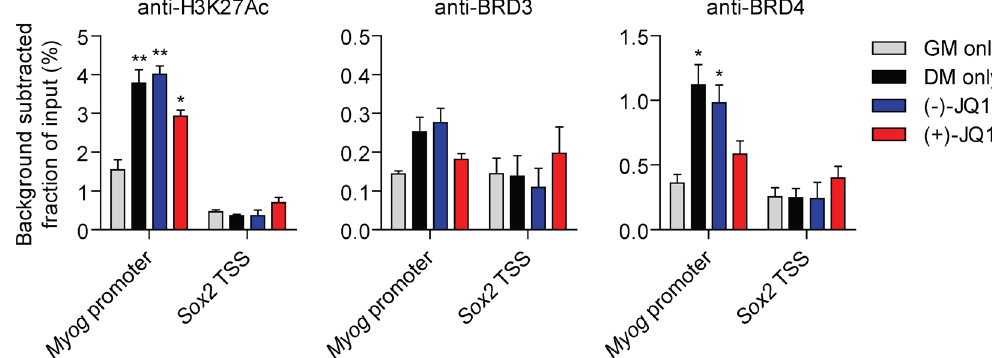
Figure 8. BRD4 is enriched at the Myog promoter during myogenic differentiation. Chromatin was harvested from undifferentiated C2C12 cells (two days in GM), differentiated cells (2 days in GM, followed by 3 days in DM), and differentiated cells treated with either ( − )-JQ1 or ( + )-JQ1 (1 μ M). Sonicated chromatin was precipitated with anti-H3K27Ac, anti-BRD3, anti-BRD4 or IgG (negative background control) antibodies. Genomic DNA was amplified by qPCR using primers for the Myog promoter or the Sox2 TSS (a putative negative control locus). Enrichment is expressed as the fraction of non-precipitated input samples after subtraction of the background IgG signal. For BRD3, one way ANOVA analysis was significant ( P = 0.0399), but no pairwise Bonferroni post test reached significance at the P < 0.05 level. All values are mean + SEM, n = 3 independent experiments, statistical comparisons are to the GM only group, * P < 0.05, ** P < 0.01, *** P < 0.001 (one-way ANOVA, Bonferroni post hoc